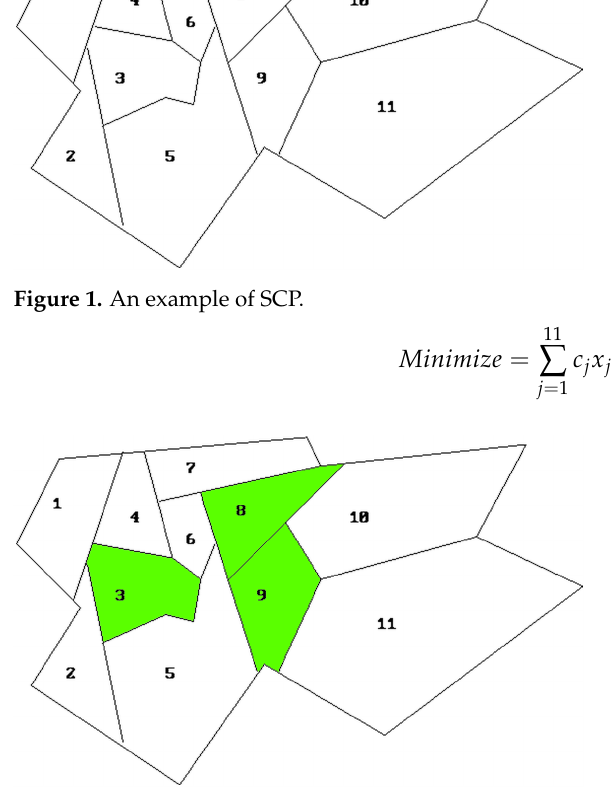
Figure 2. Solution to the practical example of